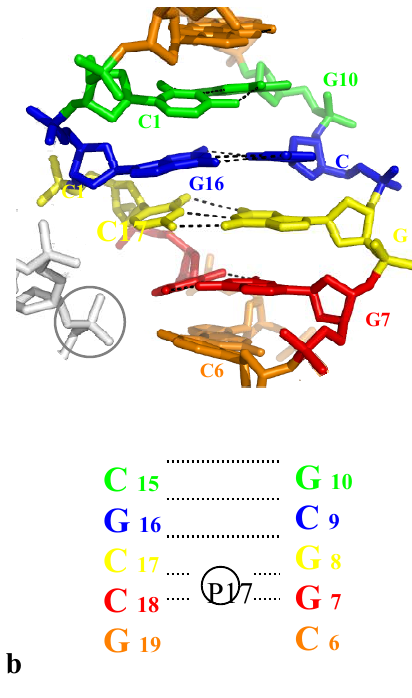
Figure 5. ( a ) Shift of the base pairing in the dodecamer d(ACCGGCGCCACA). The backbone of the fitted molecule is represented in grey. The bases that should be normaly paired are represented with the same color; ( b ) The corresponding region of the dodecamer d(ACCGCCGGCGCC) that displays a normal base